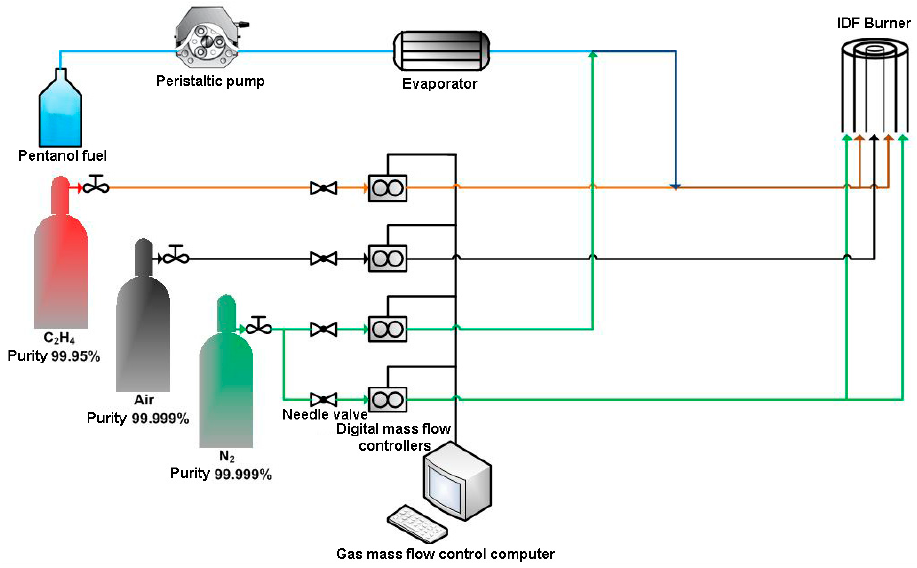
Figure 1. Schematic diagram of experimental system. Table 1. Physical properties [32] and related information of the pentanol isomers.